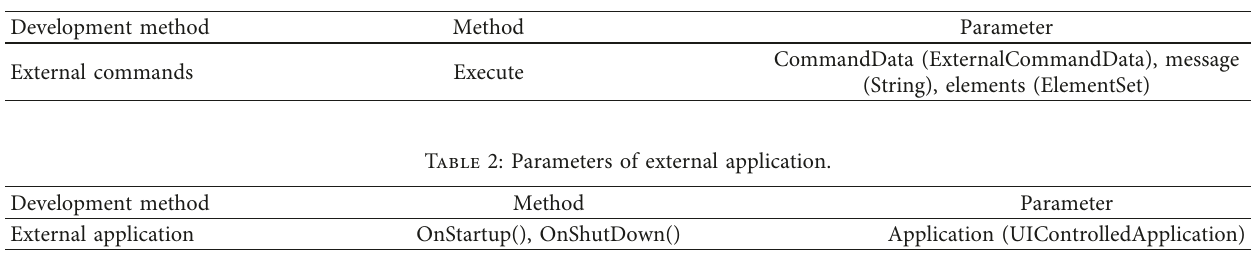
Figure 1: Development technology road map. Table 1: Parameters of external command.